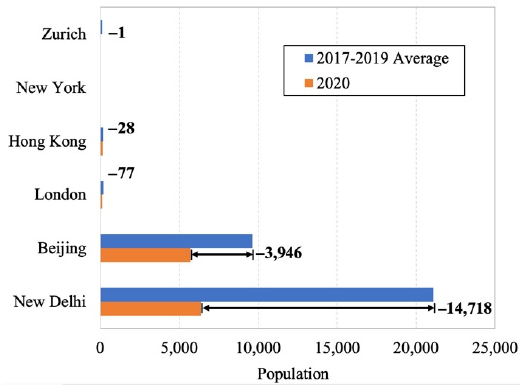
Figure 5. Mortality rate for six selected cities.